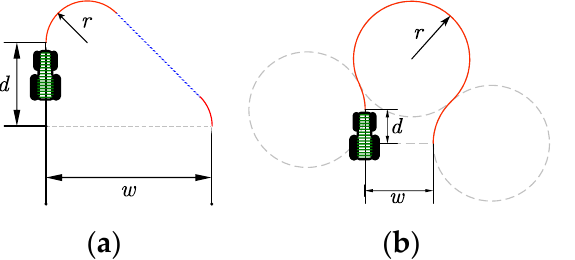
Figure 2. Schematic diagram of the turning model for a tractor ( a ) Π -Turn; ( b ) Ω -Turn. Based on the above path planning model, this paper designs a path optimization scheme for multiple unmanned tractors. The design of a multi-tractor driving route can avoid incomplete operation or repeated operation. The simplest scheme is to divide the peach orchard into several sub areas, and then assign different tractors to operate in the divided areas. The schematic diagram of block operation is shown in Figure